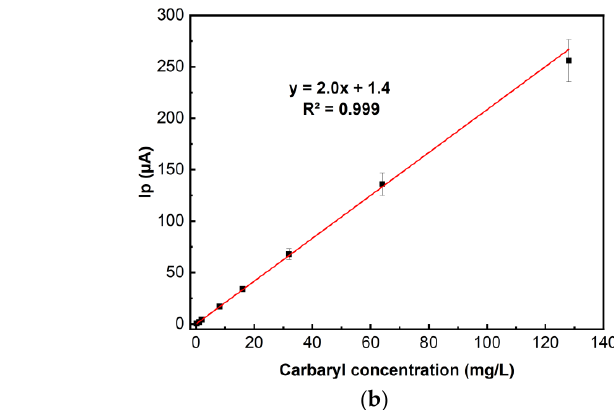
Figure 8. ( a ) Anodic LSVs of carbaryl (increasing concentration 0; 0.25; 1.0; 2.0; 8.0; 16.0; 32.0; 64.0; 128.0 mg/L in 96% ethanol and deionized water (1:1)) at LRGO grid electrode in PBS (pH 6.86) at 300 mV/s. The adsorptive accumulation time of carbaryl from the solution was 10 min. ( b ) Calibration dependence of the LSV anodic peak height on carbaryl concentration. To investigate the LRGO grid electrodes for the determination of carbaryl in fruit juices, we have explored the effects of juice matrix components on the anodic LSV peak current of carbaryl (Figure 9).